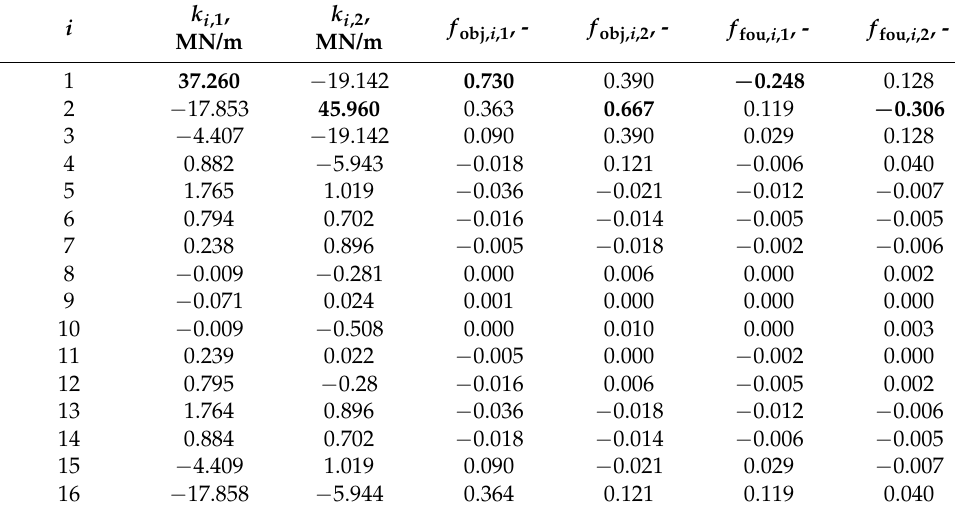
Table A4. Tank parameters calculated for n = 16 and k jack = 2579 MN/m, k pist = 110 MN/m and k fou = 150 MN/m (elements, for which i = j , that is, k j,j , f obj ,j,j and f obj ,j,j are given in bold).